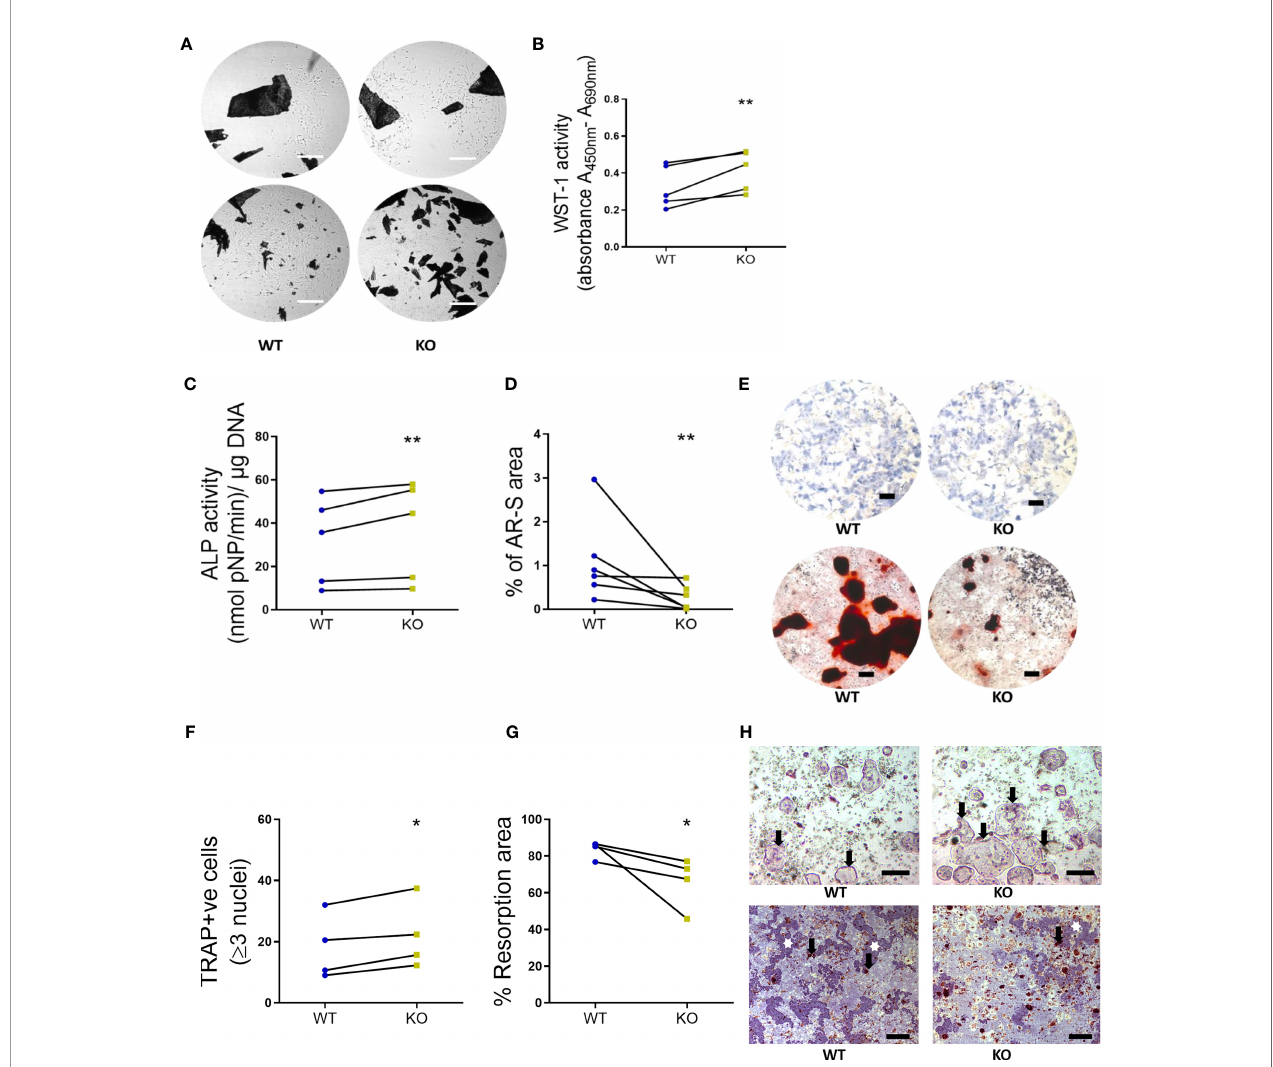
FIGURE 4 | Primary bone cells were derived from 8-week-old WT and KO mice to determine the formation and functional characteristics. (A) Representative images to show no morphological differences between the unstained osteoblasts derived from long bone explants (dark spots represent the chopped bone pieces) at initial out-growth (top panel) and as con fl uent monolayers before subculture (bottom panel). Scale bar, 200 m m. (B) Osteoblast viability (WST-1 activity, (C) alkaline phosphatase activity (ALP activity, normalized to the amount of DNA per sample) and (D) bone nodule formation (% of AR-S stained area). (E) Representative images to illustrate the ALP staining (blue stain, top panel) and AR-S staining (brown stain showing mineralized bone structures, bottom panel) between WT and KO osteoblasts. Scale bar, 200 m m. (F) Osteoclast number (TRAP positive cells), (G) the resorption area excavated from the dentine substrate (expressed as a percentage of total dentine surface). (H) Representative images to illustrate the multinucleated TRAP positive osteoclasts (black arrows, top panel, scale bar, 50 m m) and resorption pits (white stars, bottom panel, scale bar, 200 m m) excavated by osteoclasts (black arrows, bottom panel) differentiated from the spleen of WT and KO littermate pairs. Statistical signi fi cance was tested with either Student ’ s unpaired t-test/Mann-Whitney test where *P-values < 0.05, **P-values < 0.01 show signi fi cance from WT. Data shows mean ± SEM of n = 5 littermate mice (osteoblasts) and n= littermate 4 mice (osteoclasts) repeat experiments with 6-10 replicate wells per